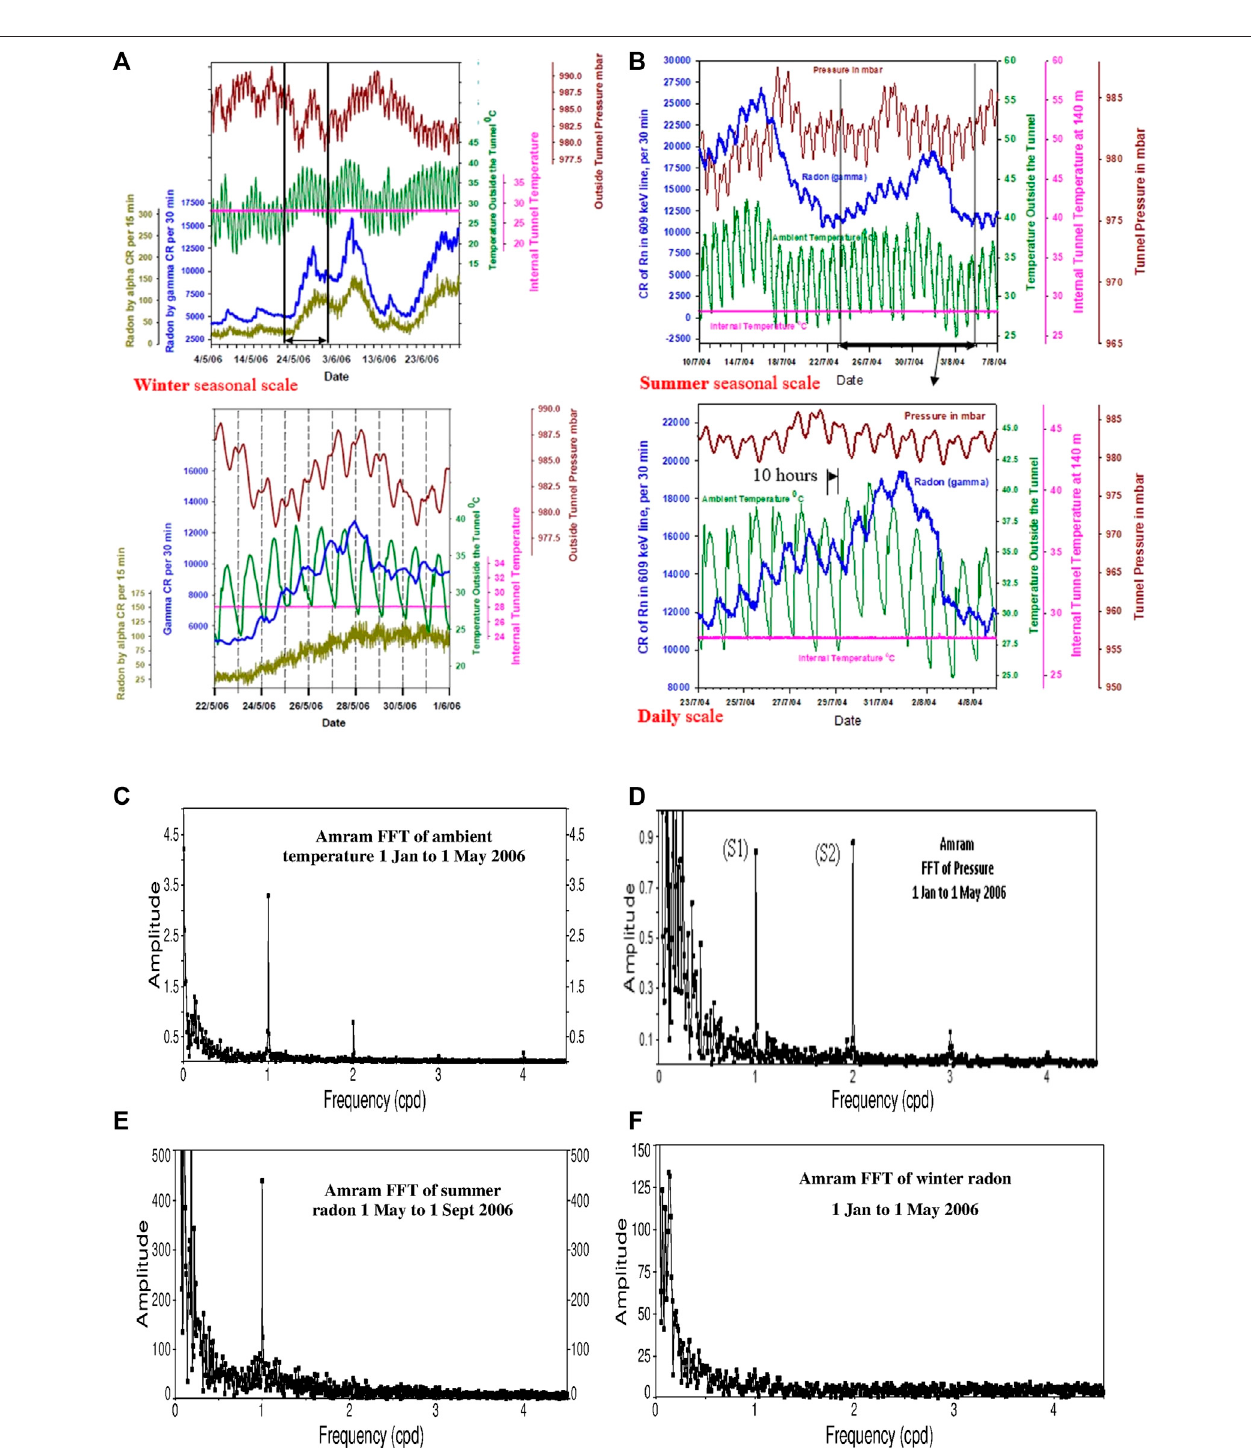
FIGURE 6 | (A) During spring, only when the external temperature ( green ) is higher than the tunnel internal temperature ( violet ) the radon diurnal variations wake up(seethewinter situation withoutdailysignalsat all,inpanel (E ),whilethemulti-day and seasonalvariationsarenotaffected. (B) During summerradonlevels withinthe tunnel ( blue ) consistently follow the summer seasonal and diurnal ambient temperature variations with a daily delay of about 10 h. (C) The ambient temperature and thesummerradonFFTamplitudespectrum (D) displayacleardiurnalcycle. (E) TheAmramradonFFTwinteramplitudehighlightingthedisappearanceoftheradon diurnalvariationsinthewinterwhenthetunnelstableinternaltemperatureof28 ± 0.3 ° Cishigherthantheoutsidetemperature.Inthis fi gure,7.3countsper30minofthe gammasensors,areequivalenttoconcentrationof1 Bq/m 3 withinthesurroundingcountryrock,and0.018countsper15 minofthealphaparticledetectorisequivalent also to 1 Bq/m 3 .